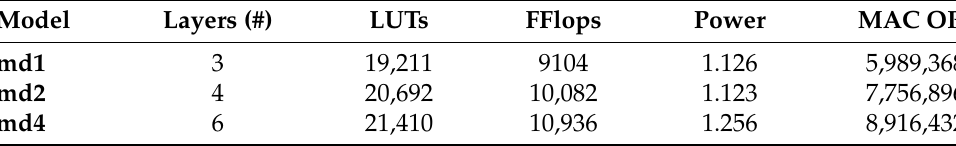
Table 11. Comparison of actual hardware performance and MAC operations of various models.